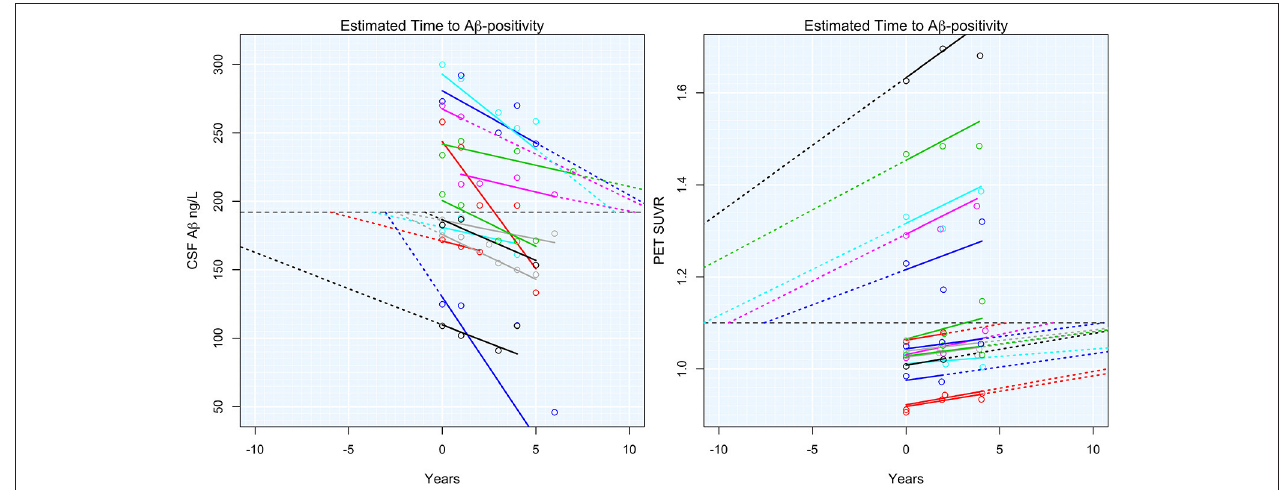
FIGURE 1 | Estimated time to A β -positivity. Subject-specific estimated slopes of either CSF A β or PET A β are plotted against the time from baseline. Dashed colored lines show the projected time to or from A β -positivity. The horizontal dashed black lines indicate the threshold for A β -positivity.